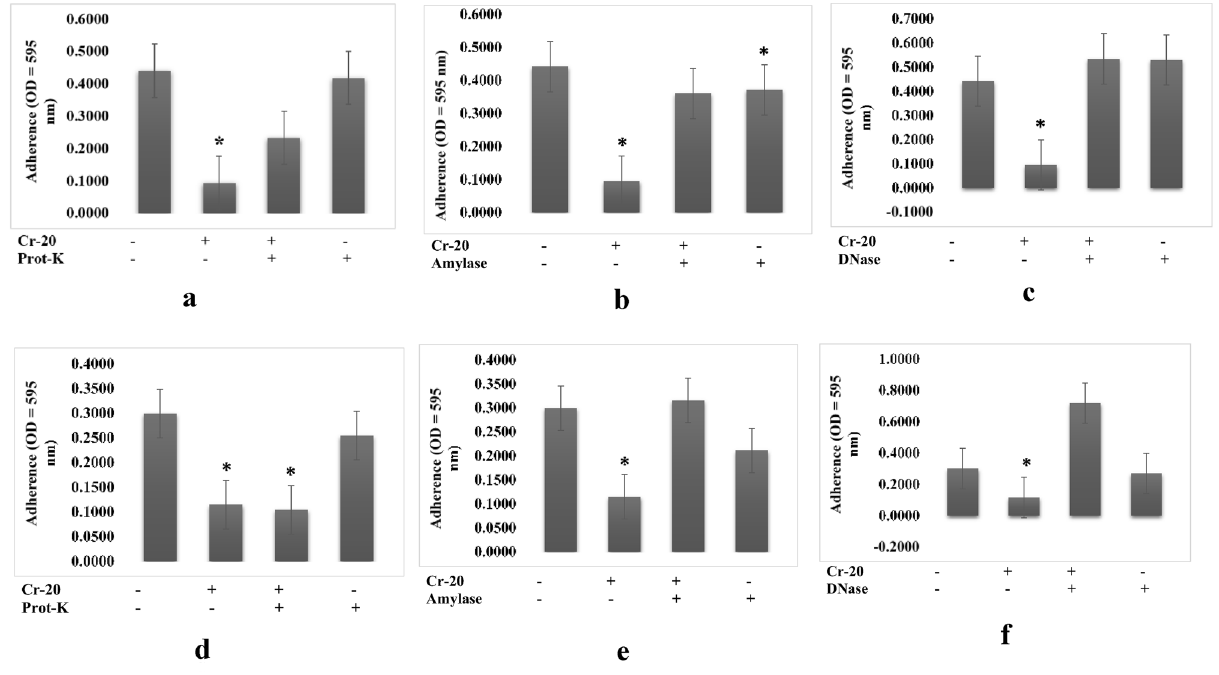
Figure 2. Characterization of extracts produced by 20PM isolate ( a – c ) which were responsible for the antibiofilm activity towards biofilm structure of A. hydrophila and ( d – f ) which were responsible for the antibiofilm activity towards biofilm structure of V. harveyi by treating the extract with amylase (1 mg/mL), proteinase K (1 mg/mL), and DNase I (100 mg/mL). (n = 6 replications; vertical bars are standard errors; *: significantly different at p <